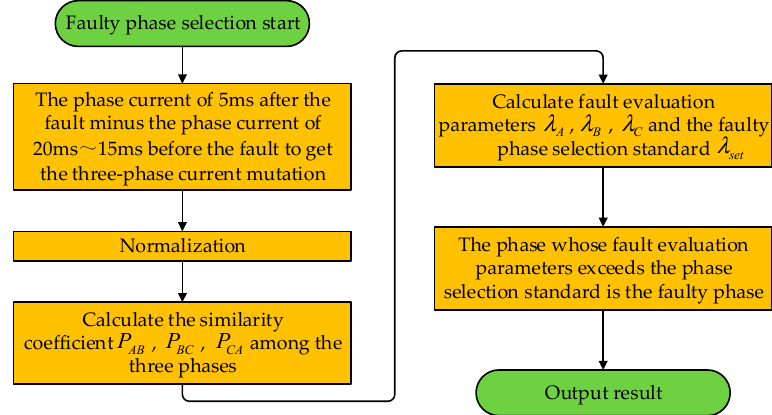
Figure 5. Flowchart of the faulty phase selection method based on HD.